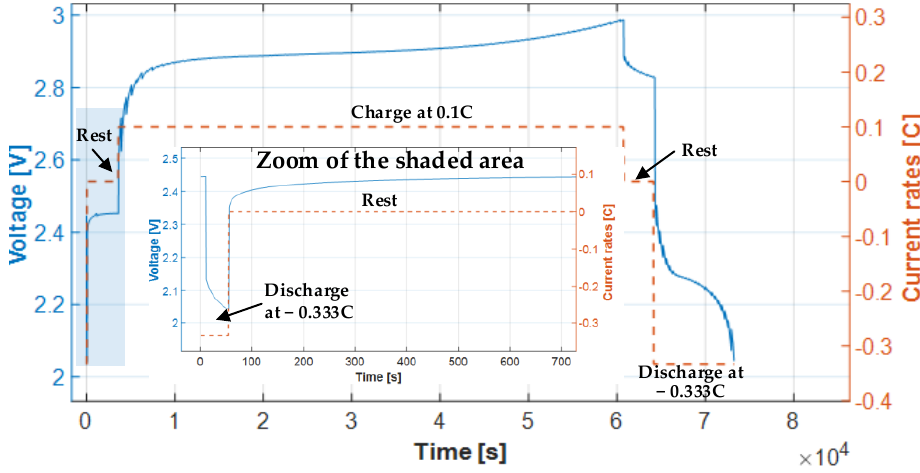
Figure 7. Determination of the rated discharge capacity C n when the two batteries were discharged at a rate of 0.333 I t = 0.67 A from 3 V to 2 V (end-of-discharge voltage). As shown in Figure 7, the two cells were discharged at a constant rate of 0.333 I t, from an initial voltage of around 2.45 V down to 2.0 V. They were then rested for 1 h, and then charged at a constant current rate of 0.1 I t for 16 h (the charging time specified by the manufacturer, as shown in Table 1) to around 3 V. After another rest of 1 h, the rated discharged capacity C n was obtained by discharging the cells at a constant rate of 0.333 It to reach the end-of-discharge voltage (2